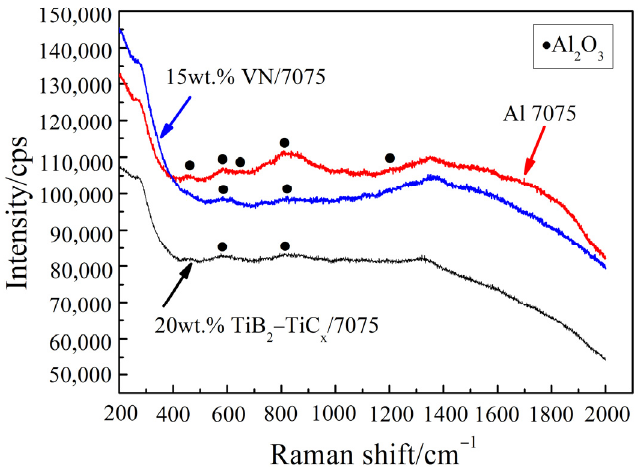
Figure 6. Raman spectrum test results of sample worn surface after wear test at room temperature. The worn surface and 3D laser scanning morphology analysis of samples after wear test of Al 7075, 15 wt.% VN/7075, and 20 wt.% TiB 2 -TiC x /7075 composites at 100 °C are